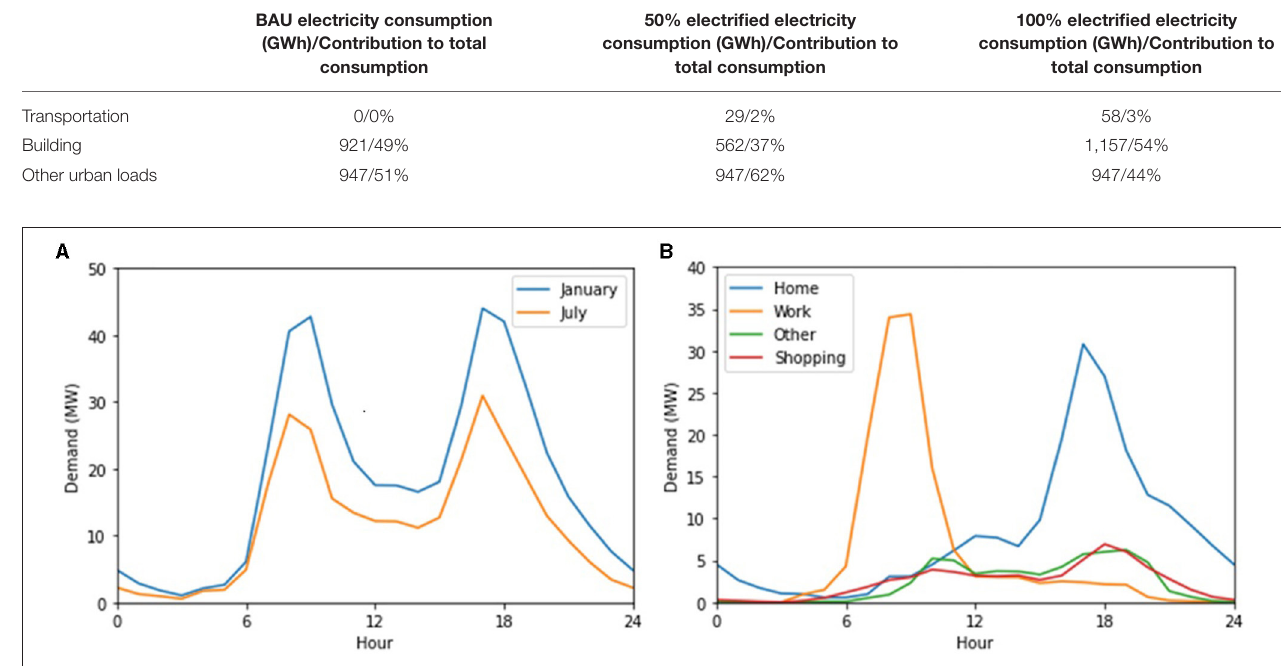
TABLE 2 | Modeled annual electricity consumption by sector based on electrified share of personal vehicles and residential building heating.